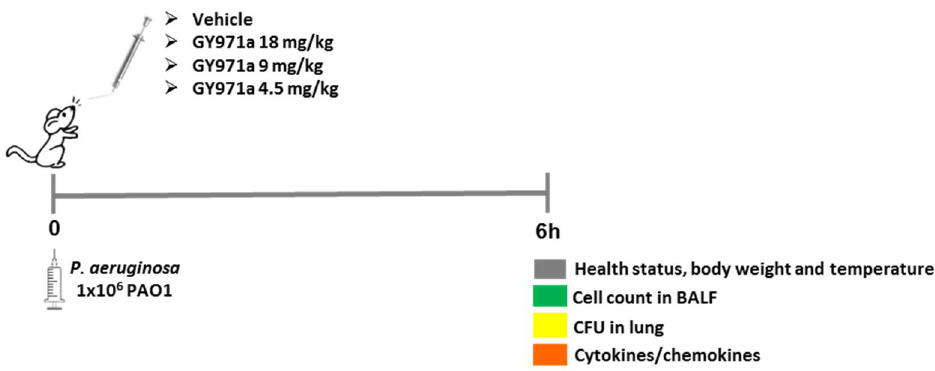
Figure 8. Scheme of the treatments and analysis in the murine model of P. aeruginosa acute infection.